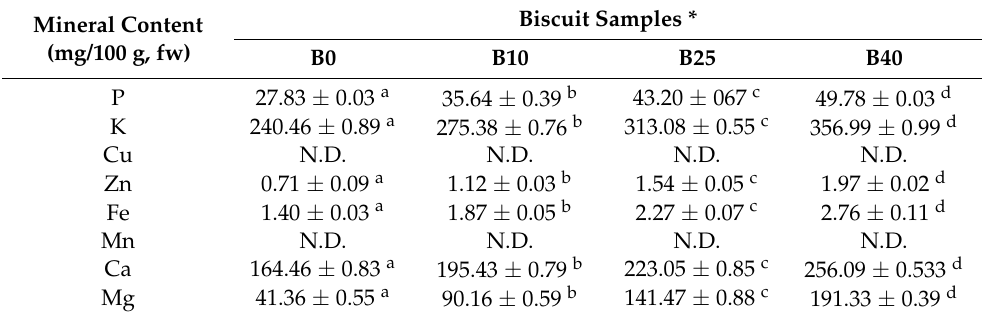
Table 5. The concentration of macro and microelements in biscuit